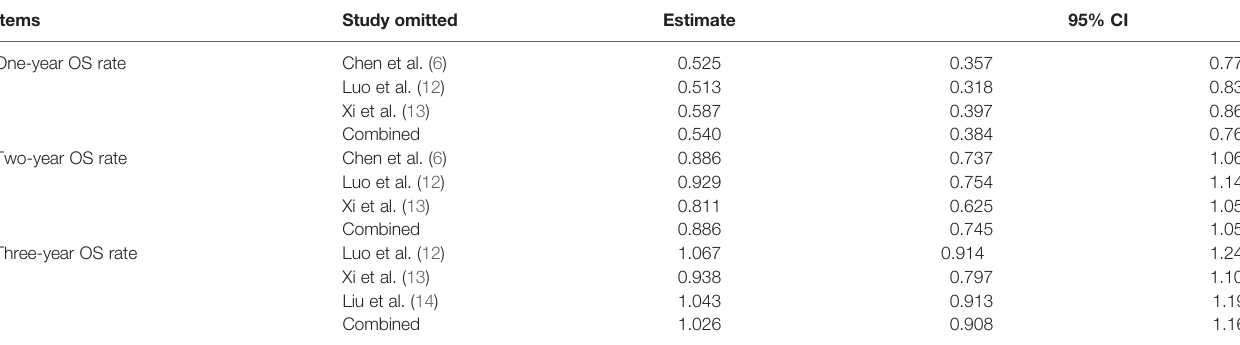
TABLE 3 | Sensitivity analysis for 1-, 2-, and 3-year OS rate (IC-CCRT vs . CCRT group). Items